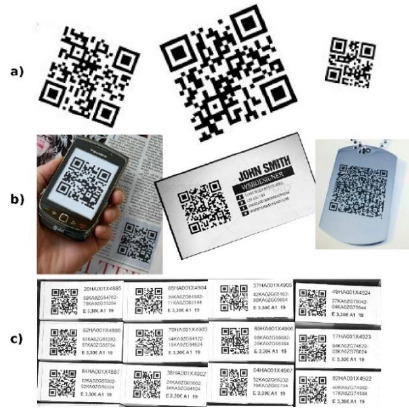
Figure 15. Transformation of the QR Code into the binary grid.